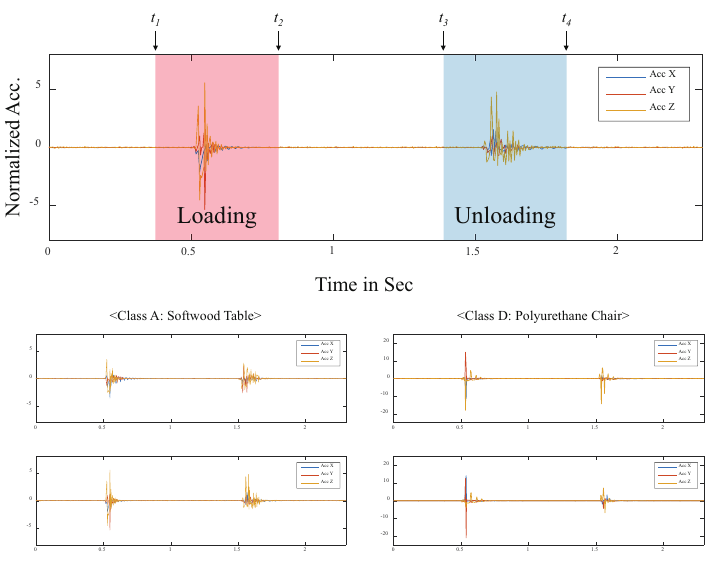
Figure 5. Examples of sample data. Signals highlighted in red (left) were captured while pulling the slug (loading); signals highlighted in blue (right) were captured while the slug crashed onto the desktop surface (unloading or